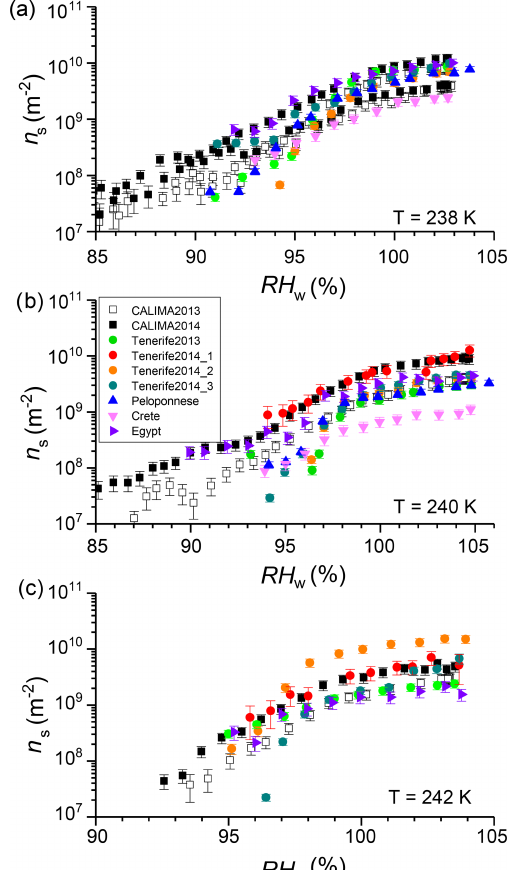
Figure 1. Ice-active surface site density at (a) 238K, (b) 240K, and (c) 242K of samples collected airborne at the Izaña observatory on Tenerife in 2013 and 2014 (circles), in Egypt, Crete, and Pelopon- nese (triangles), and n s measured in situ during the CALIMA 2013 and 2014 campaigns which took place at the Izaña